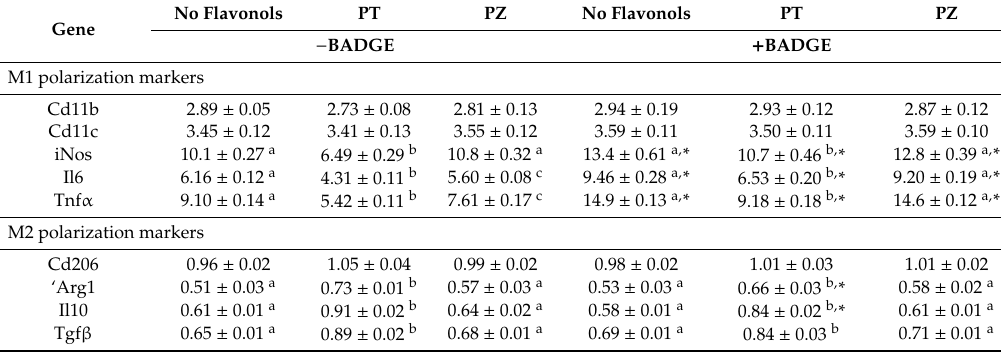
Table 4. mRNA expression in macrophages cultured in conditioned media from LPS + CoCl 2 -stimulated adipocytes co-treated with PT or PZ, with and without BADGE 1